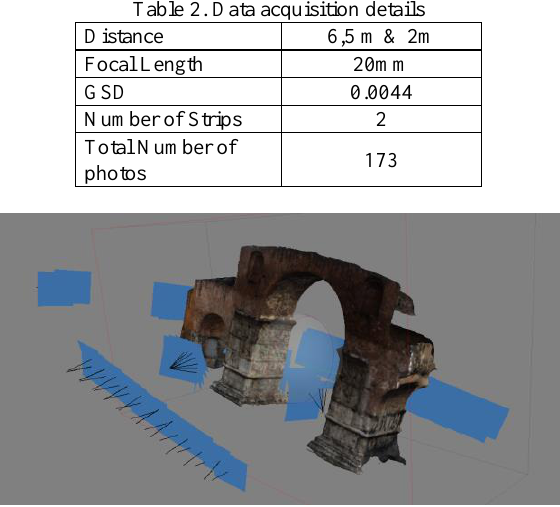
Figure 6. Strips of images captured